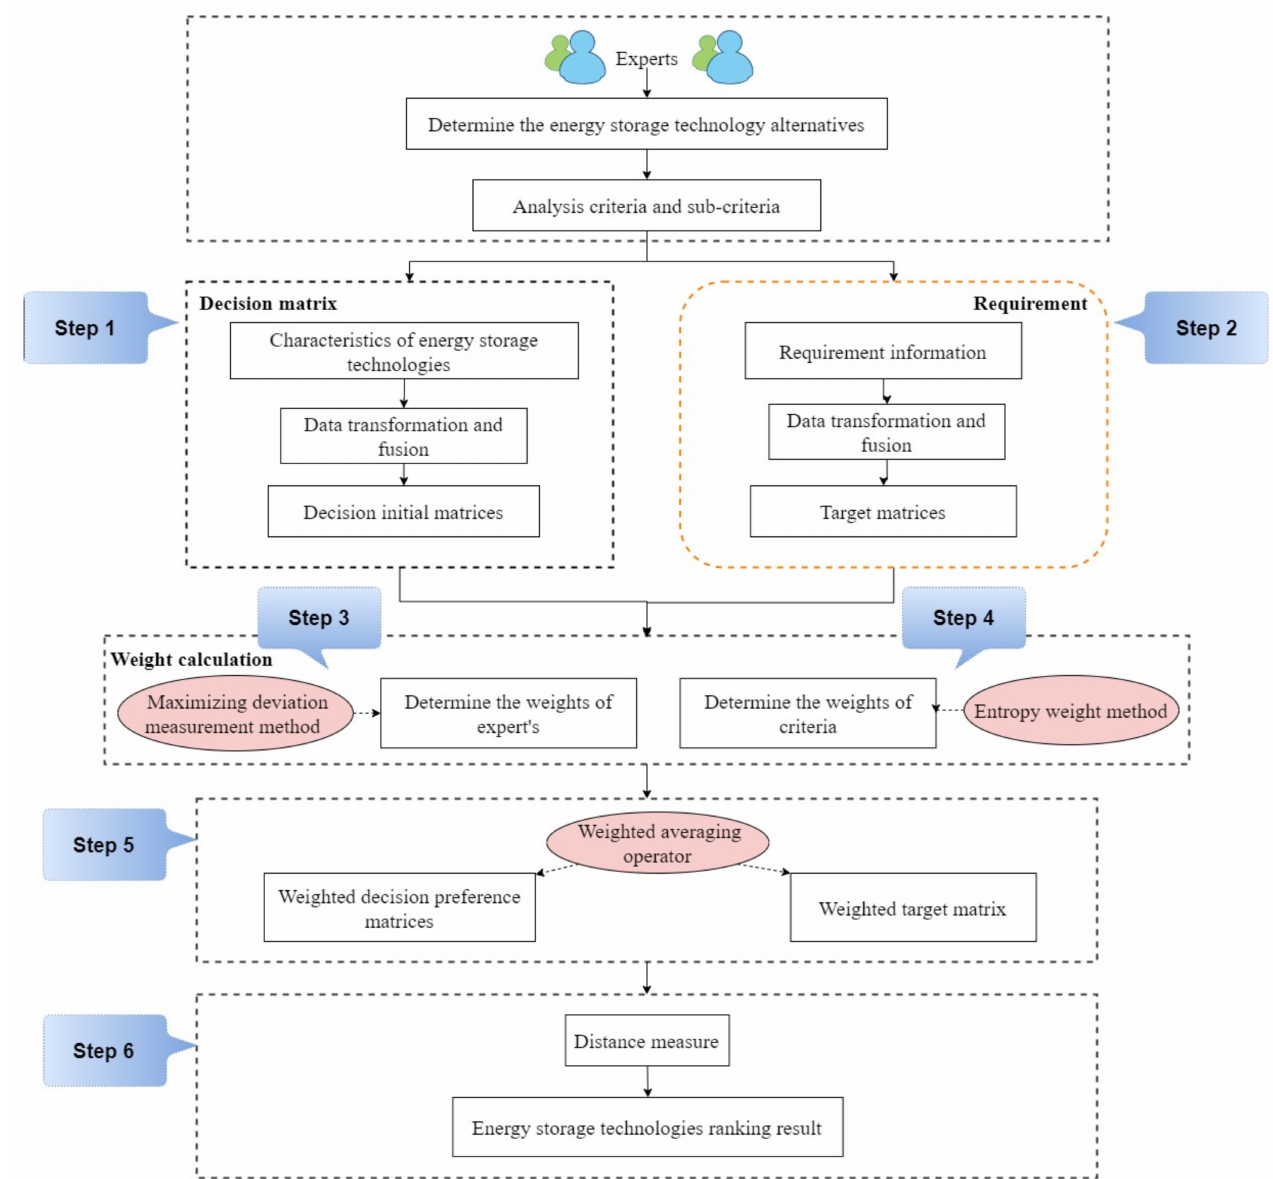
Figure 1. The decision-making framework for energy storage technology